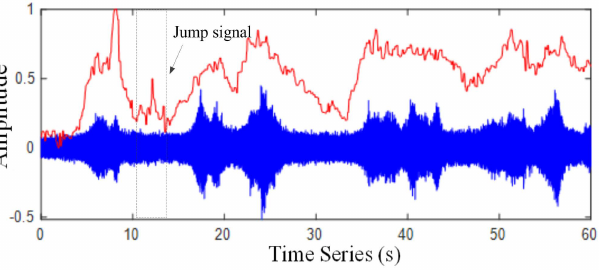
Figure 5. Waveform of traffic noise signal and the corresponding zero crossing